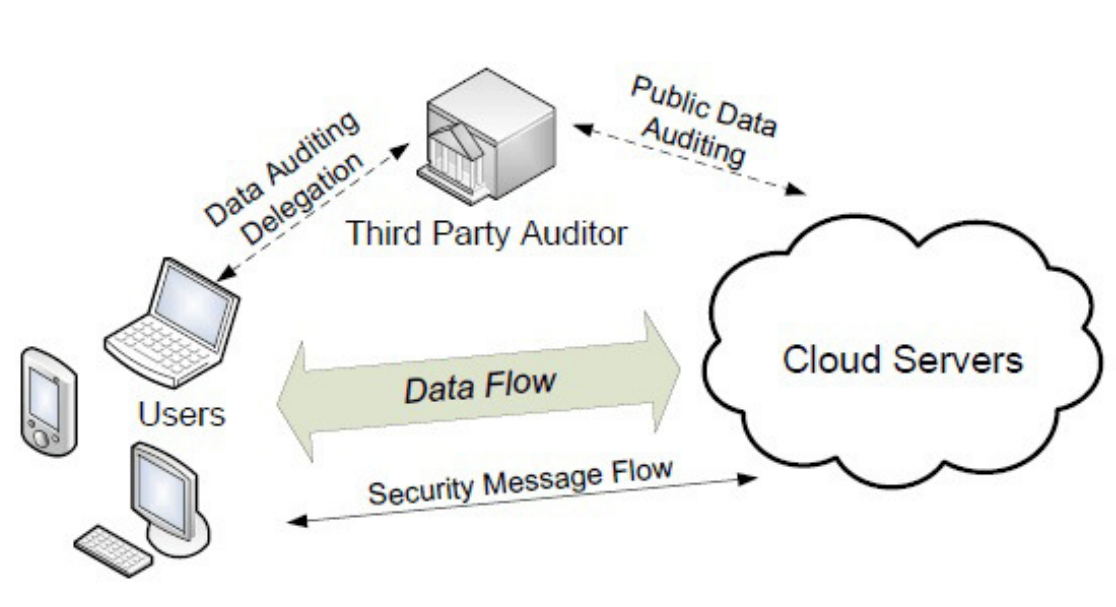
Fig. 1 The architecture of cloud data storage